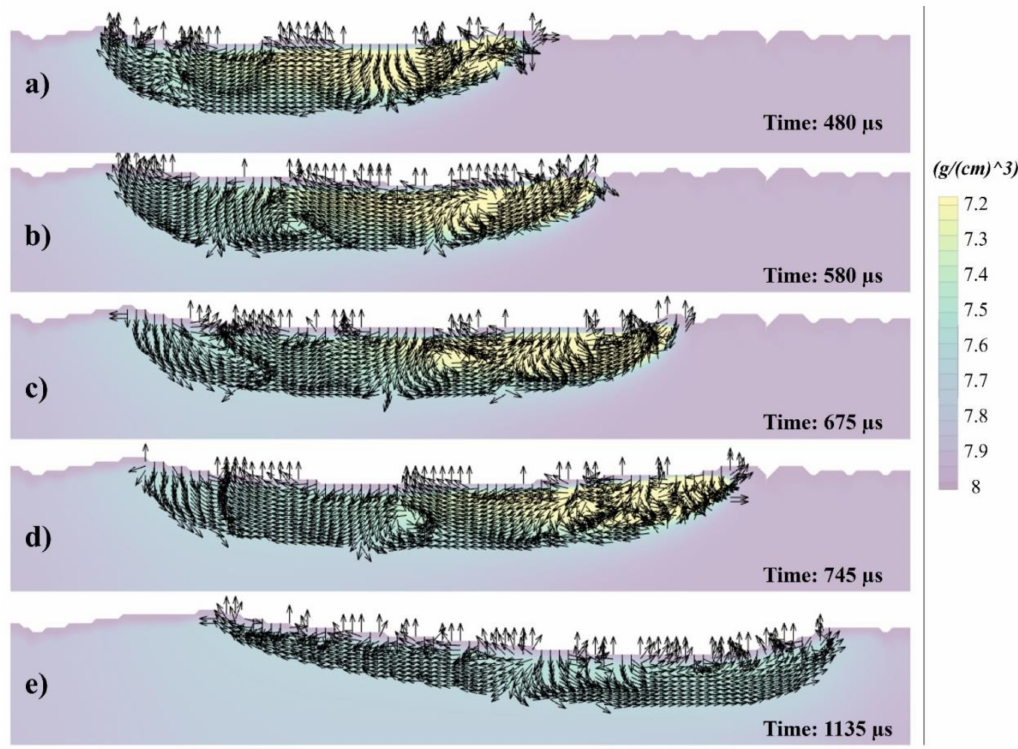
Figure 9. Velocity vectors of the cross-section at ( a ) 480, ( b ) 580, ( c ) 675, ( d ) 745, and ( e ) 1135 µ